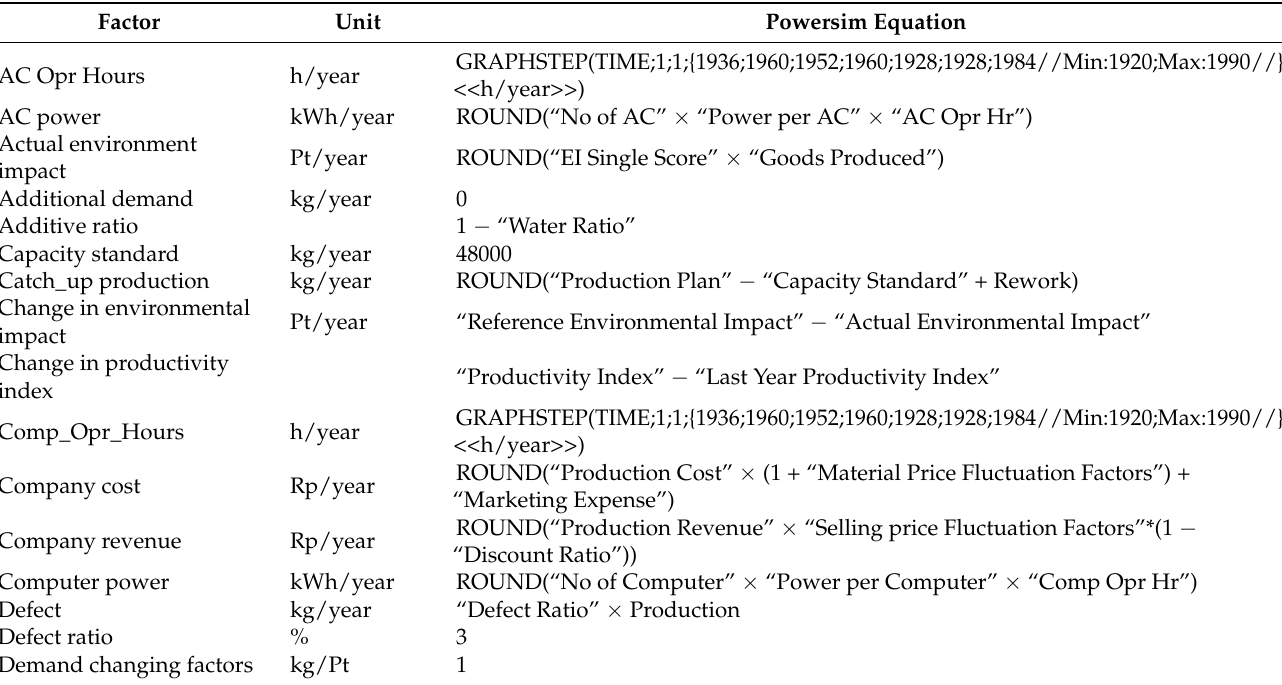
Table A2. List of Equations in